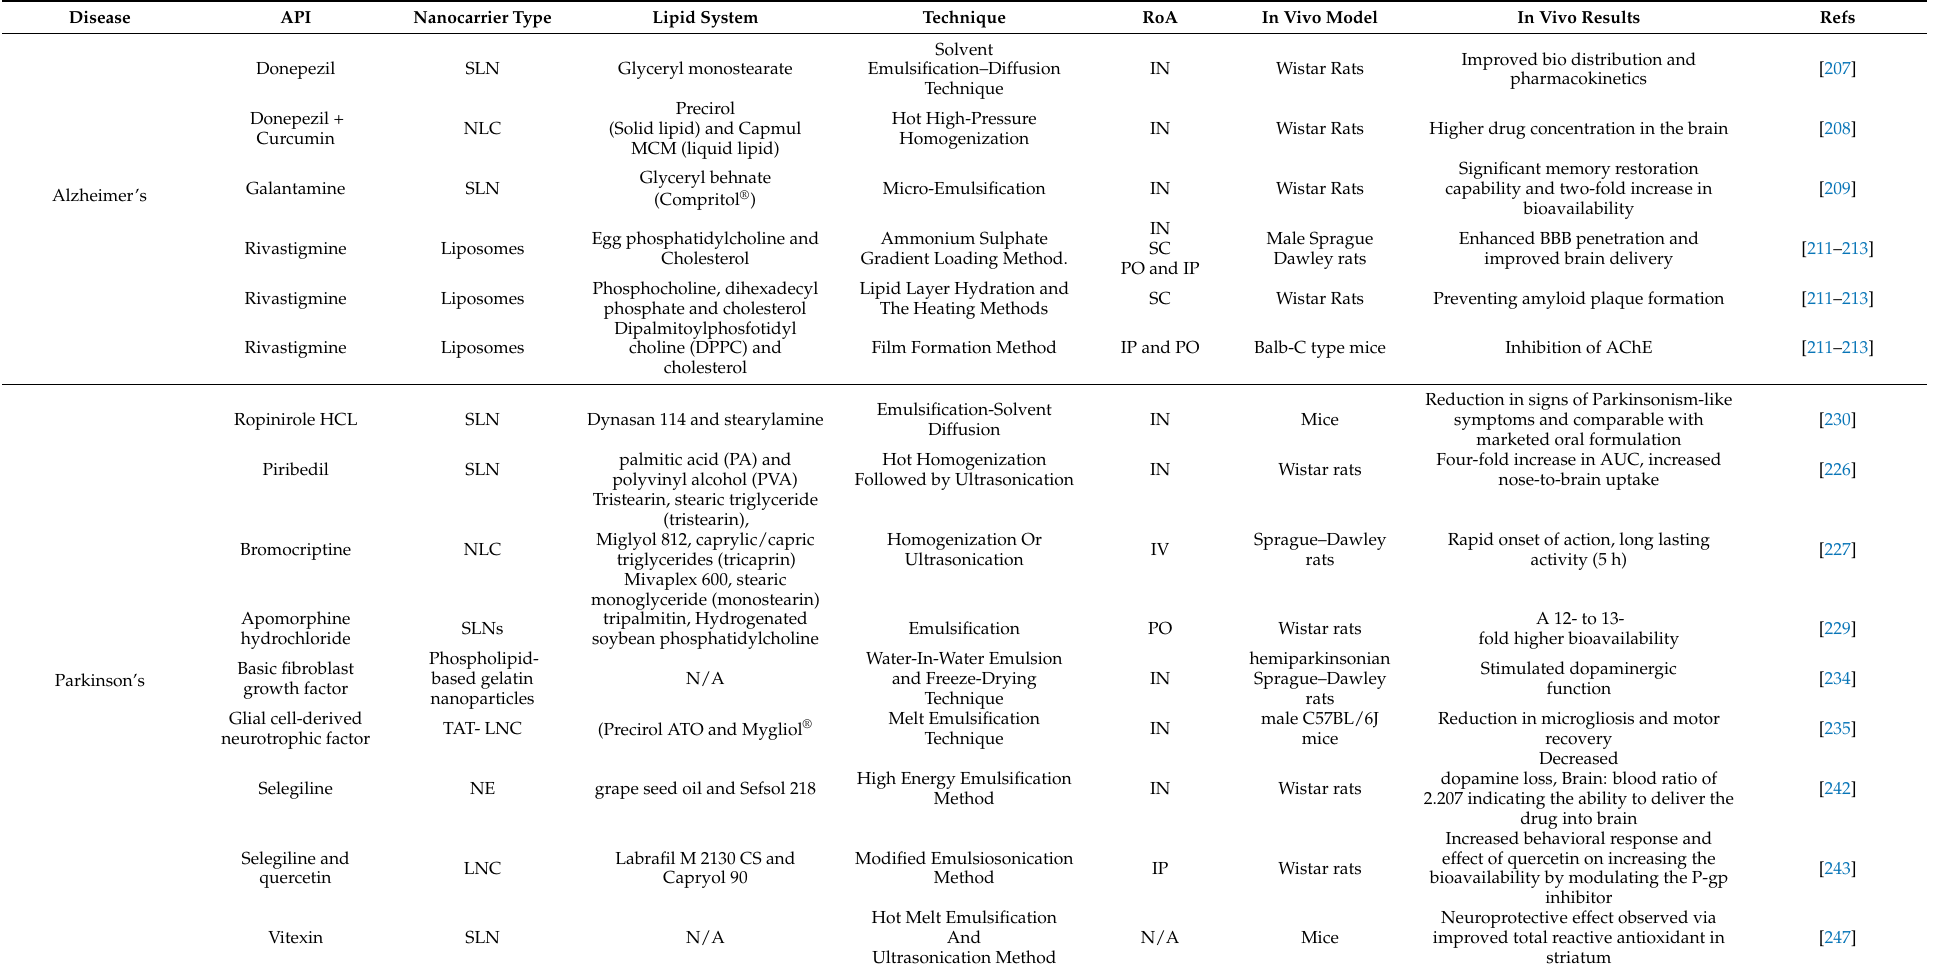
Table 1. Summary of Nanocarrier applications in CNS